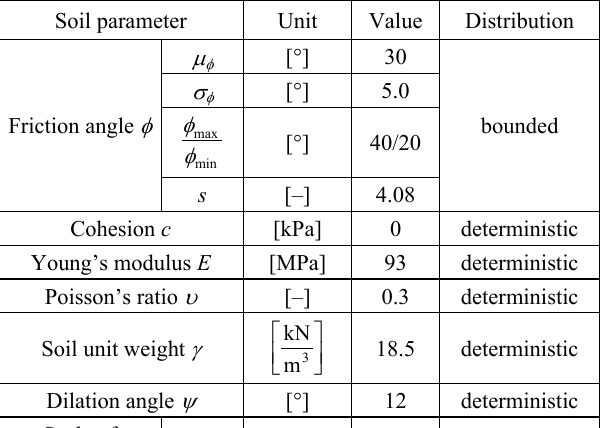
Table 9. Soil parameters used in numerical analysis of the bearing capacity of cohesionless soil Soil parameter